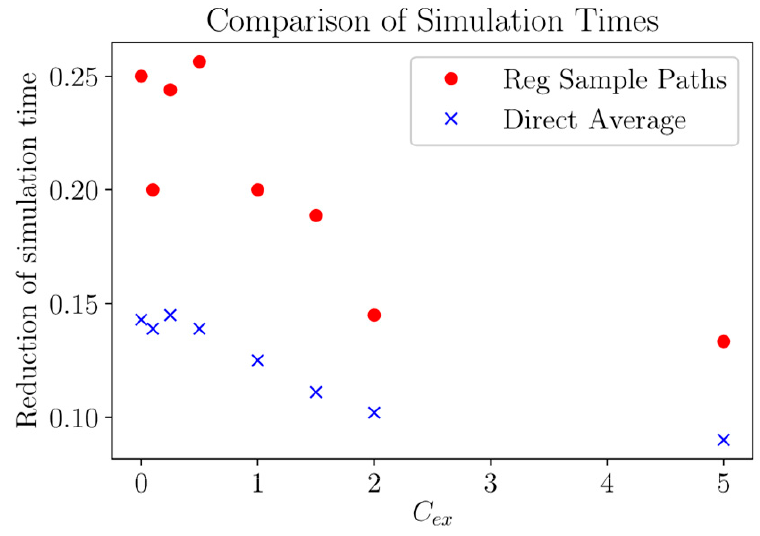
Figure 4. Simulation time of the regular sample path method and direct averaging relative to that by SSA.